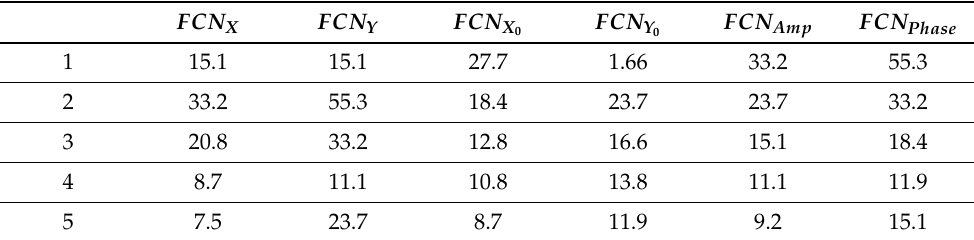
Table 2. Spectral analysis of the FCN time series (after changing the resolution from daily to monthly): first five dominant frequencies (unit: months). FCN X FCN Y FCN X 0